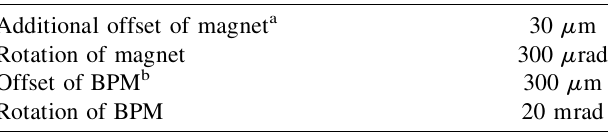
TABLE I. Errors in the standard